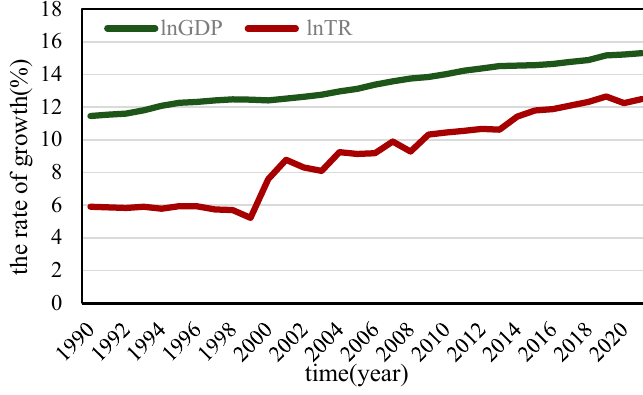
Figure 2. Sequence trend change diagram. Table 1. Results of stationarity test of each variable.